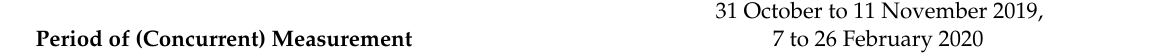
Period of (Concurrent) Measurement